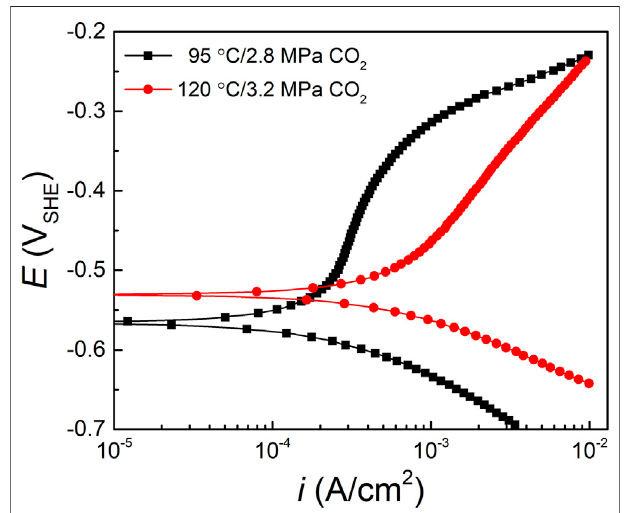
FIGURE8 | Polarization curves ofHP-13Cr SSafter LA immersion in the FW at 95 ° C/2.8MPa CO 2 and 120 ° C/3.2 MPa CO 2 .